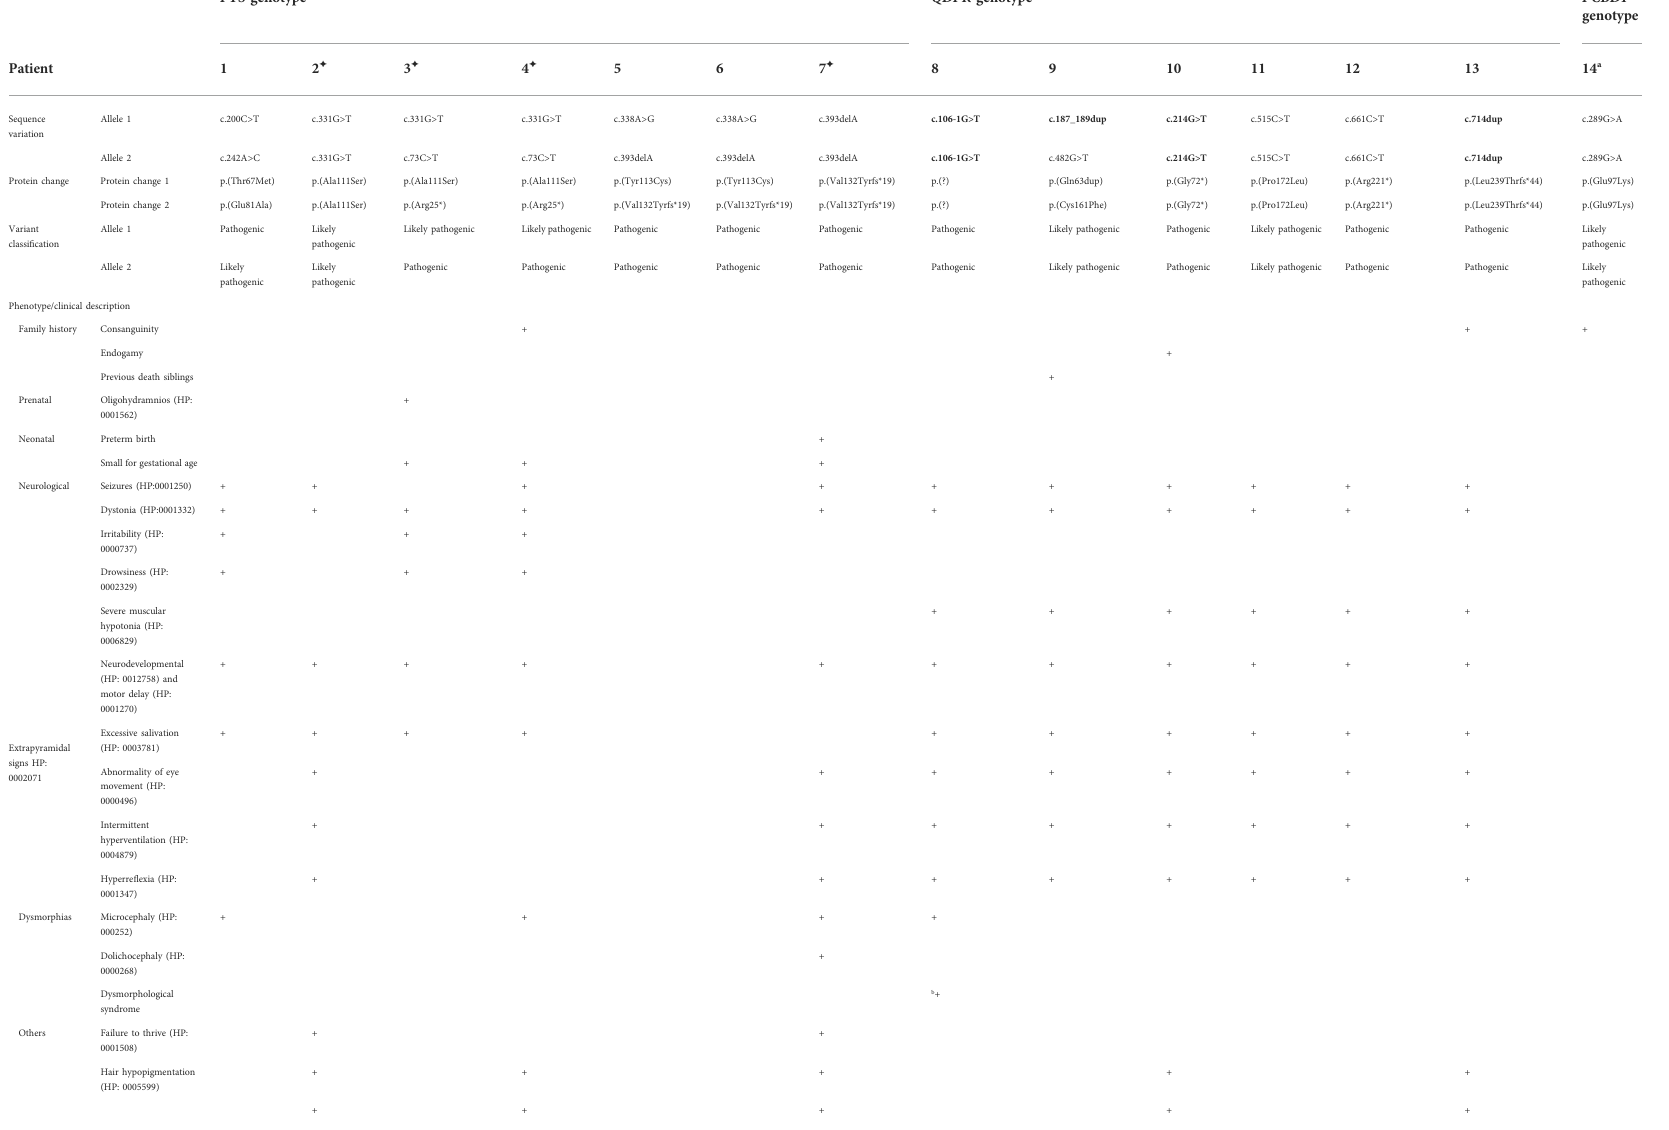
TABLE 4 Genotype/phenotype description of Mexican patients bearing clinically relevant biallelic PTS , QDPR , and PCBD1